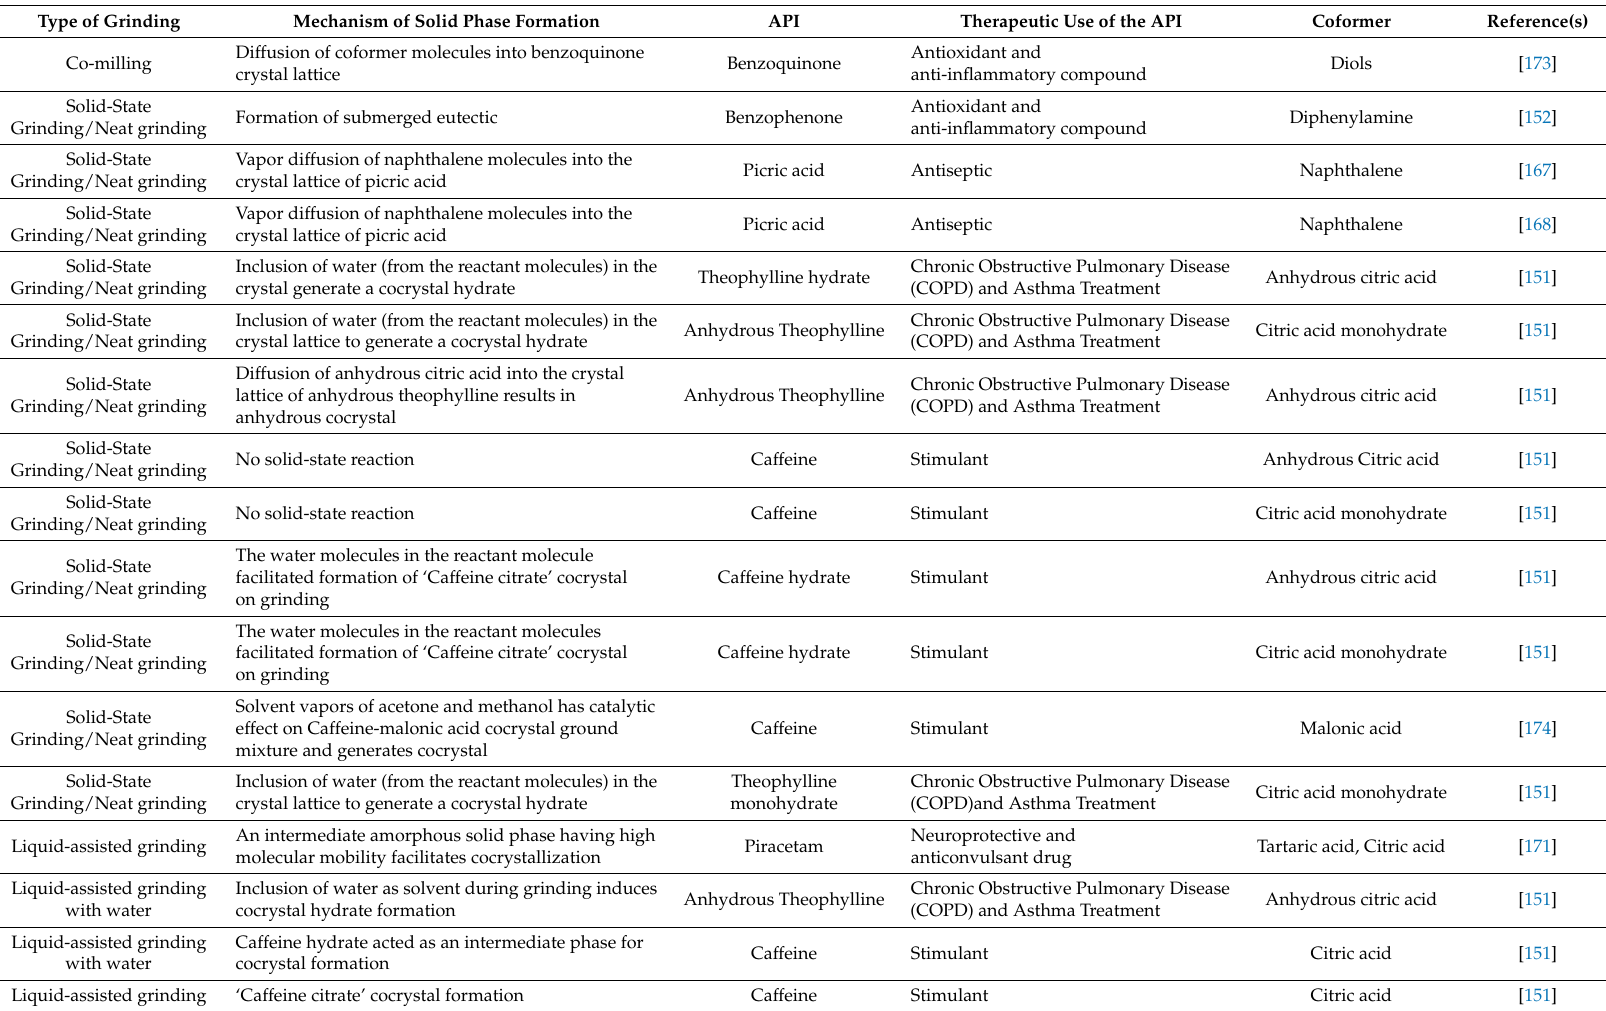
Table 8. Summary of various reports available in literature on using grinding to synthesize